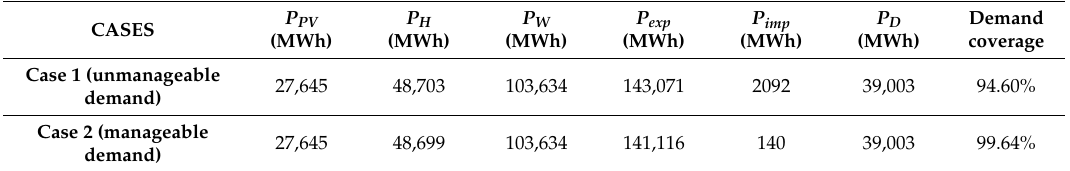
Figure 5. Evolution of the annual demand of cases with and without intraday demand management. Table 6. Comparison of annual production, export and import results with and without demand management.